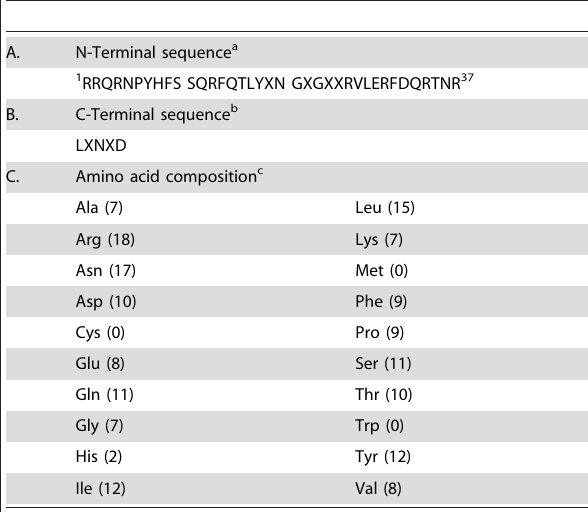
Table 1. N-Terminal sequence, C-terminal sequence and amino acid composition of blad.